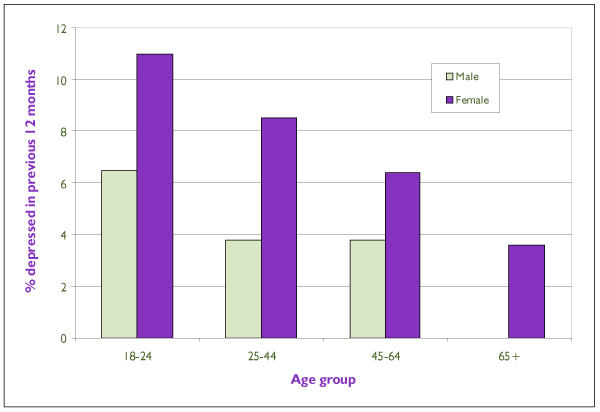
Unadjusted prevalence of depression, by sex and age group, Canada, 1994–1995: proportion depressed in previous 12 months. Source: National Population Health Survey, 1994–1995 (Health Rep 1996;7(4)).